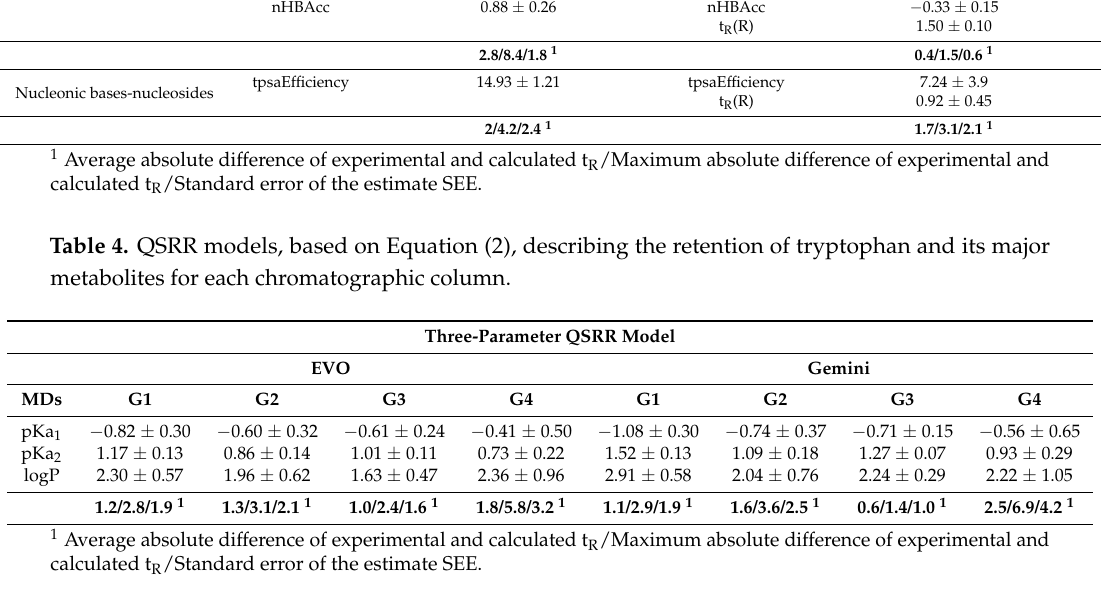
Table 5. QSRR models, based on Equation (1), describing the retention of tryptophan and its major metabolites for each chromatographic column using the other column as a reference